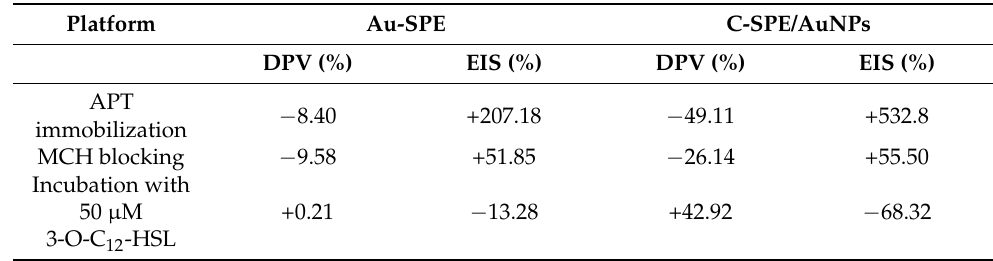
Table 1. The performance of an Au-SPE surface vs. C-SPE/AuNPs with respect to the aptasensor development steps. ∆ Signal (%) compared to the previous